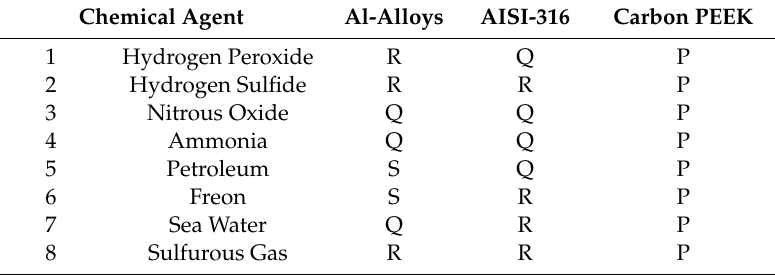
Table 2. Chemical compatibility of carbon PEEK [32]. P = high, Q = medium, R = poor, S = not recommended.